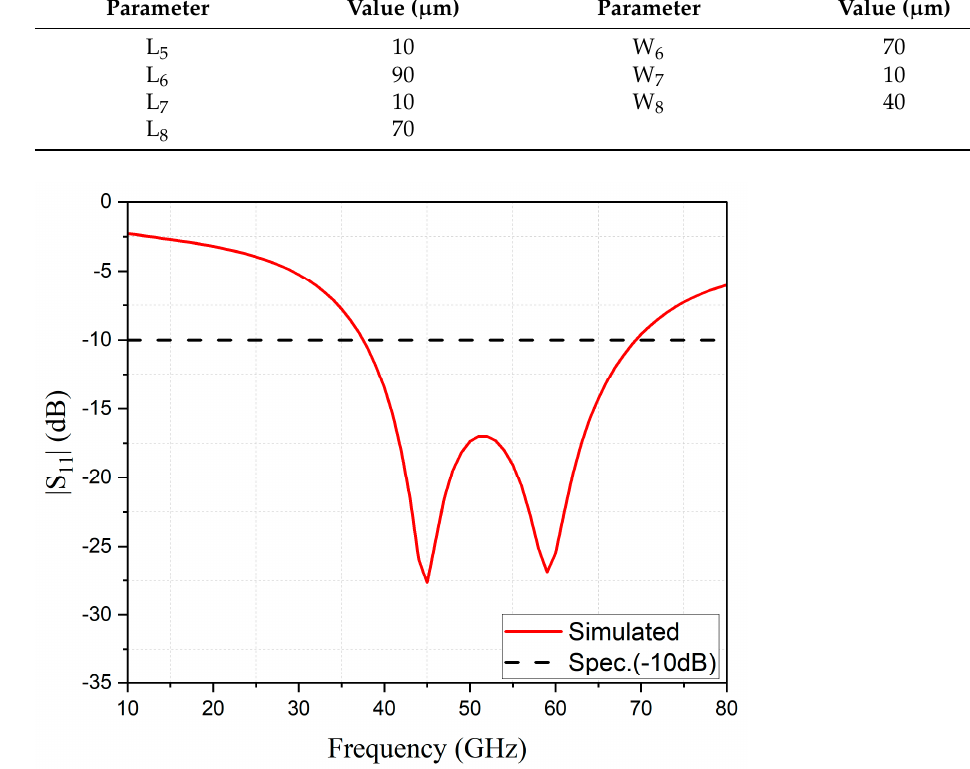
Figure 6. Simulated S11 of the antenna.